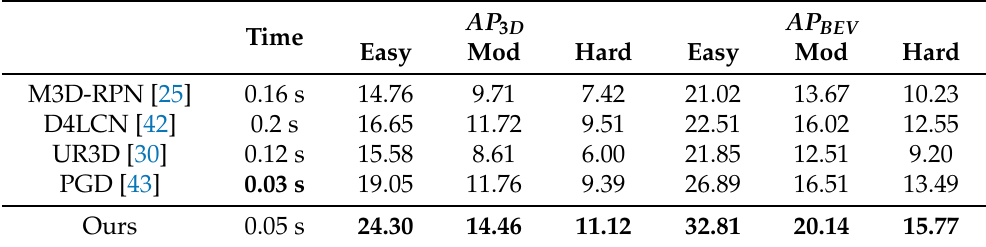
Table 1. The comparison of AP 40 between our framework and image-only 3D localization frameworks for car on the Bird’s Eye View object detection task and 3D object detection task. (The time is reported from the official leaderboard with slight variances in hardware). We use bold type to indicate the best result.